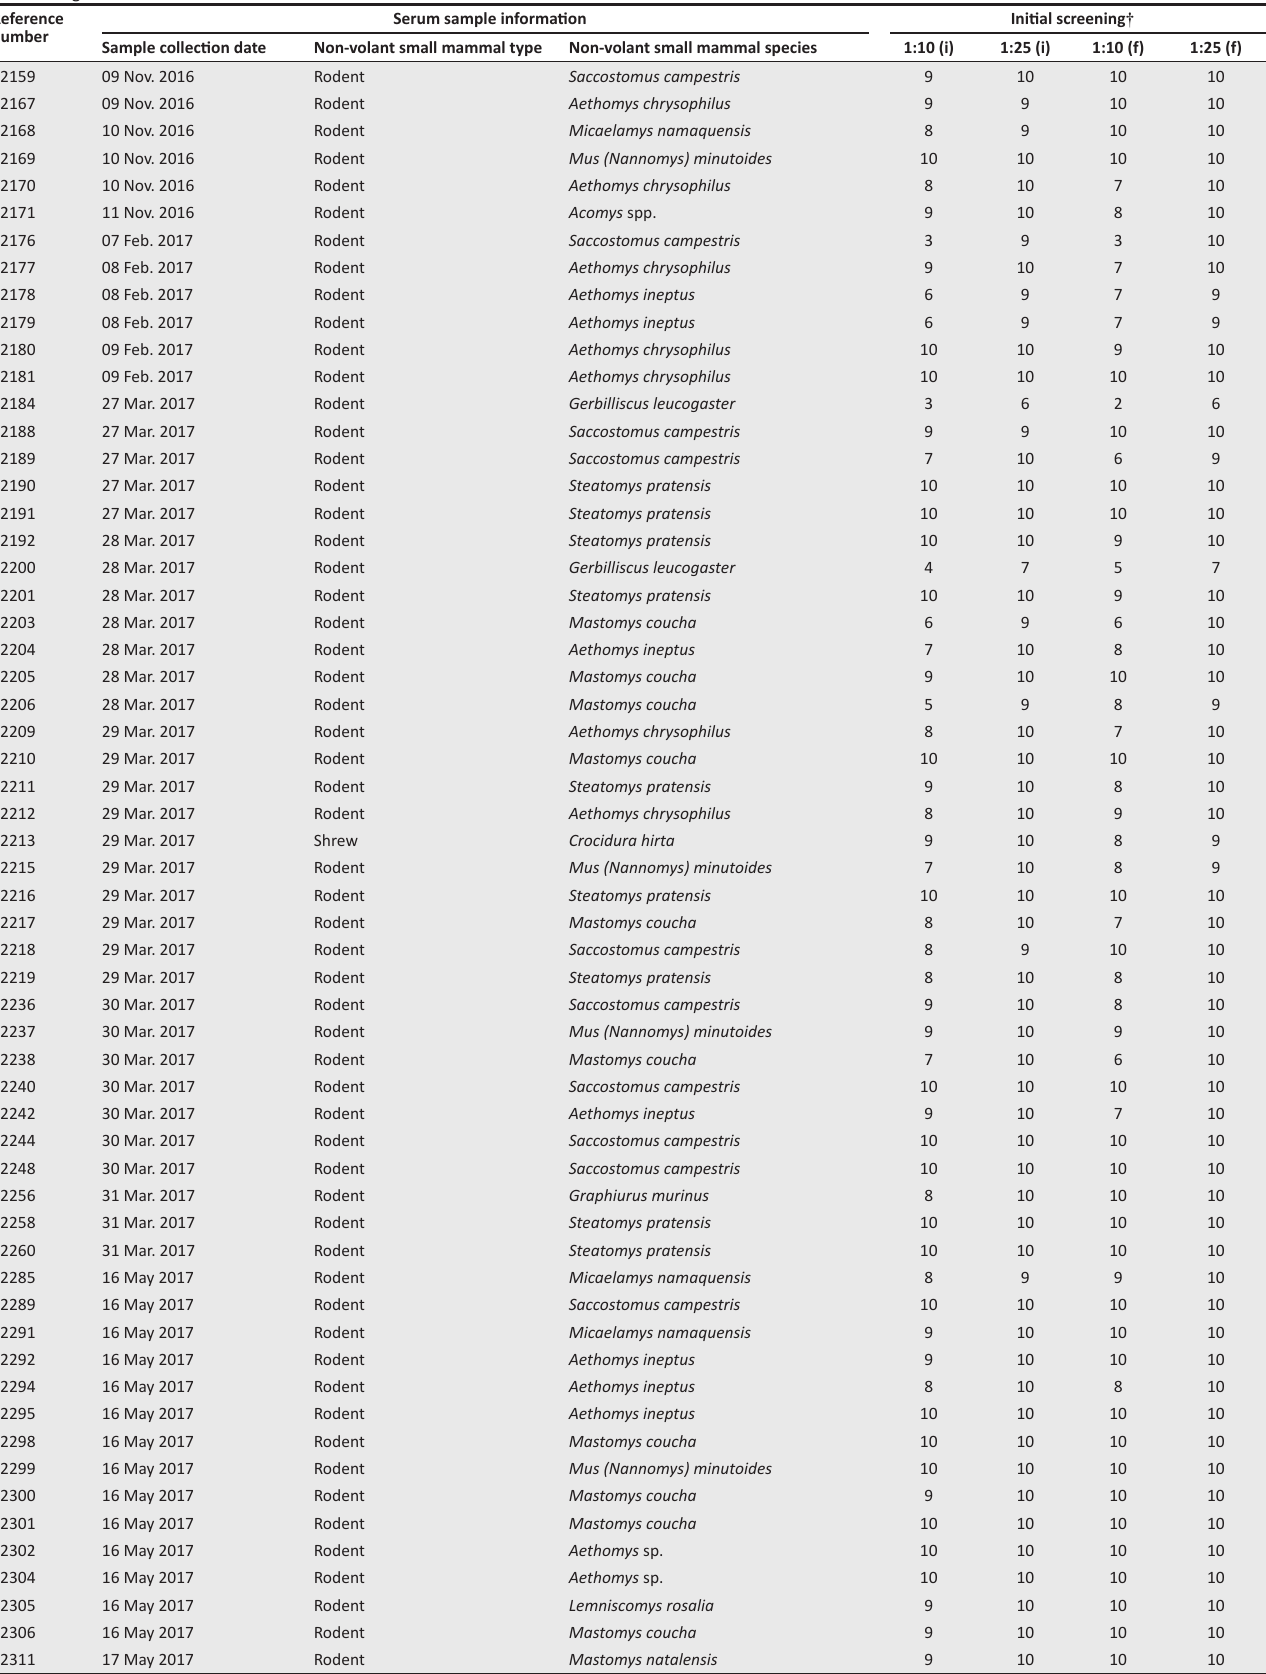
TABLE 4-A1 (Continues...): Micro-neutralisation test results of all non-volant small mammal serum samples that tested negative for the presence of Mokola virus neutralising antibodies. Reference